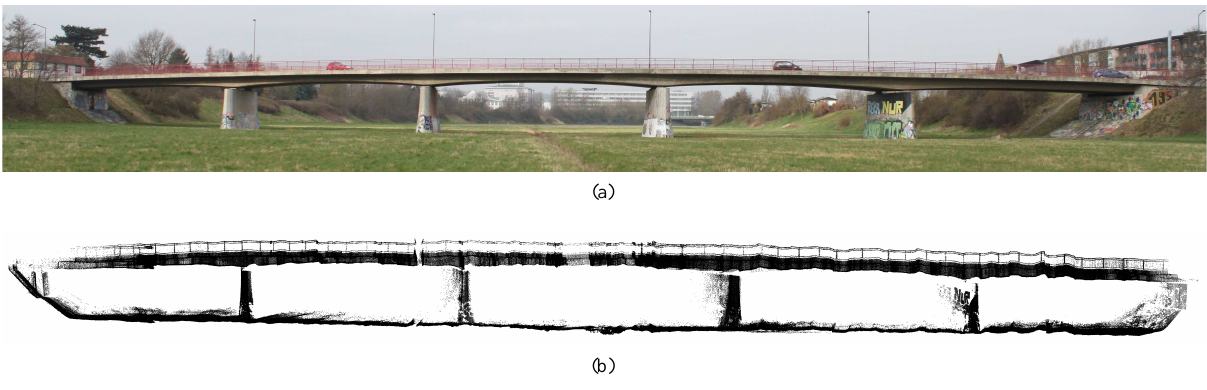
Figure 2: (a) Image of the investigated bridge. (b) Overview of the entire 3D point cloud based on data from LSRF. eight coaxial mounted rotors (Figure 1). For the determination